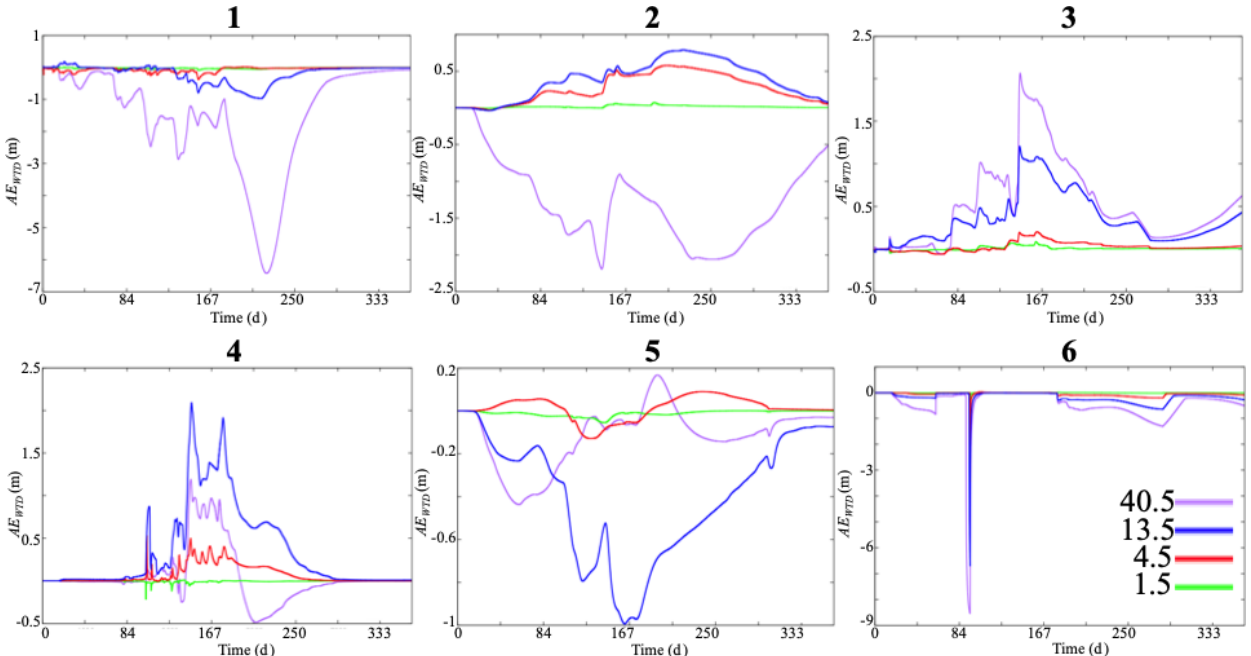
Figure 13. Absolute error of the water table depth (AE WTD ) with respect to the highest spatial resolution of meteorological forcing (0.5km) at six selected